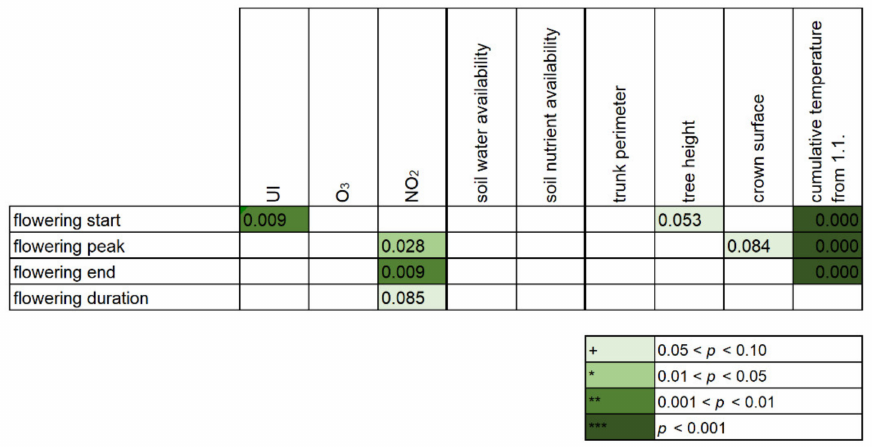
Figure 7. Heatmap showing the relationships of flowering season traits (onset, peak, end and dura- tion) against various environmental parameters (ridge regression, backwards stepwise elimination).